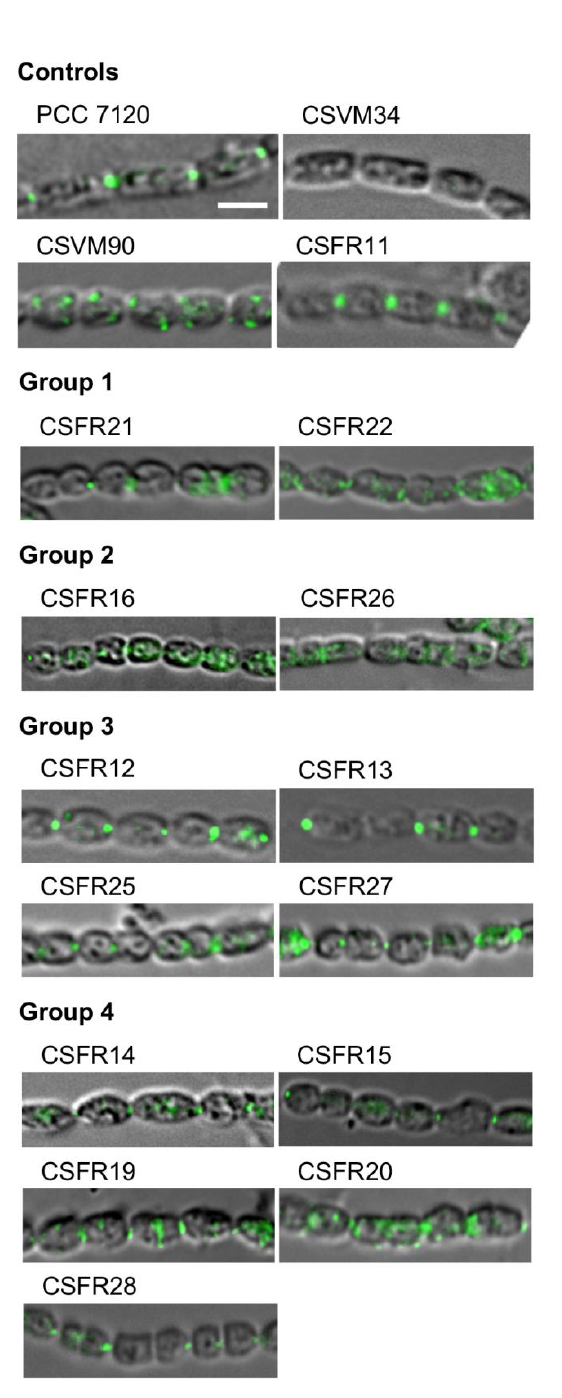
FIGURE 4: Immunolocalization of SepJ in filaments of the indi- cated strains grown in BG11 medium. Immunolocalization was performed as described in Materials and Methods with antibod- ies raised against the coiled-coil domain of SepJ. The mutants are organized according to the phenotypic groups described in the text. Scale bar, 3